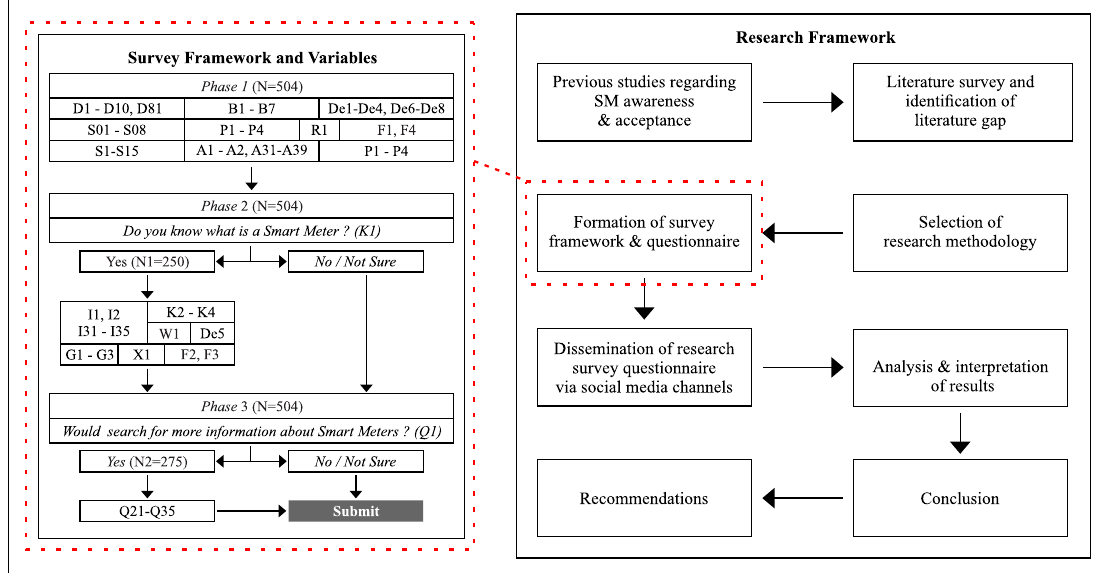
Figure 1. Research